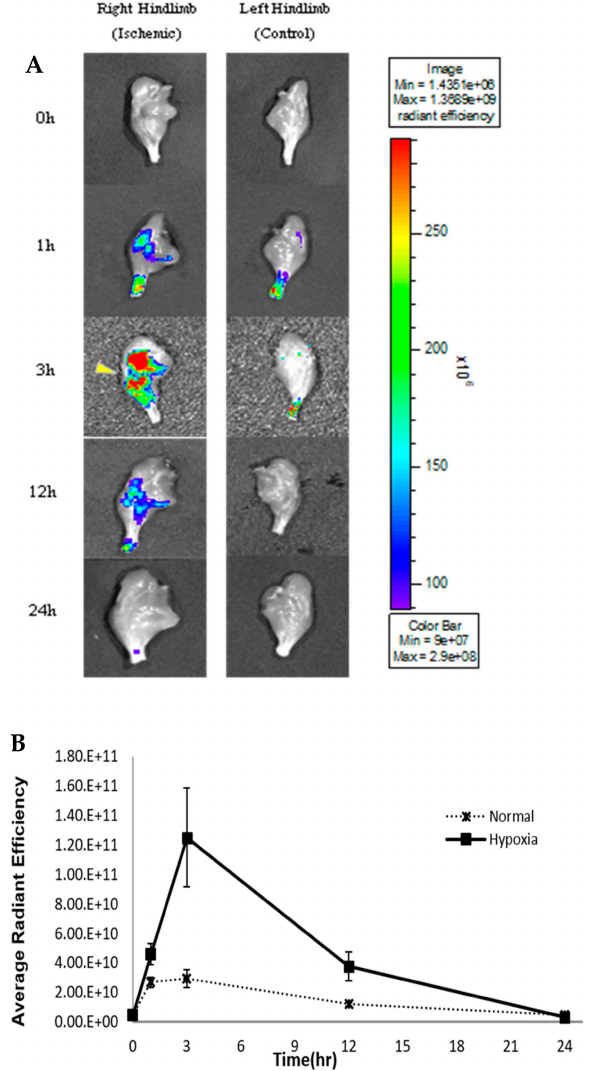
Figure 3. In vivo fluorescence imaging of endogenous H 2 S by fluorescence probe in a rat model. ( A ) Fluorescence images (Lumina II) at the following time points: 0, 1, 3, 12 and 24 h. Left legs show normal and right legs show hypoxic conditions ( n = 4). Yellow triangle represents hypoxic region. ( B ) Fluorescence intensity of both normal and ischemic regions across 24